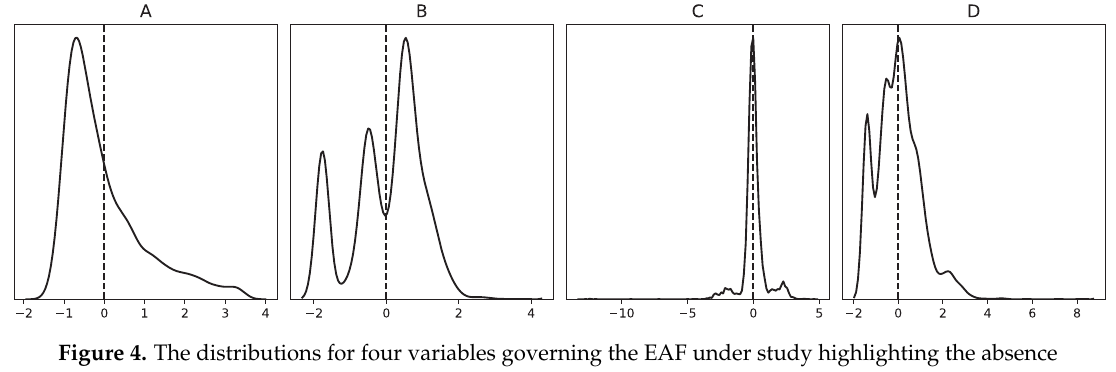
Figure 4. The distributions for four variables governing the EAF under study highlighting the absence of the Gaussian distribution. All values are normalized, and the dashed lines indicate the mean values. ( A ): TTT. ( B ): Charged weight of internal scrap. ( C ): Total charged weight of raw materials. ( D ): Charged weight of shredded